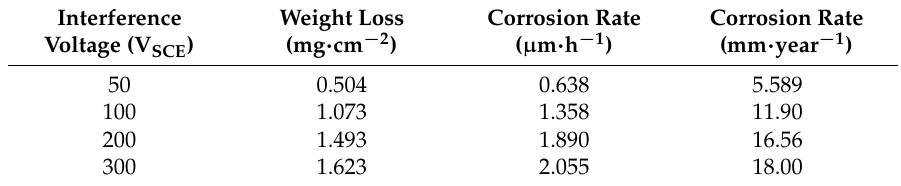
Table 4. Weight loss and corrosion rates of X80 steel under 50–300 V HVDC interference.